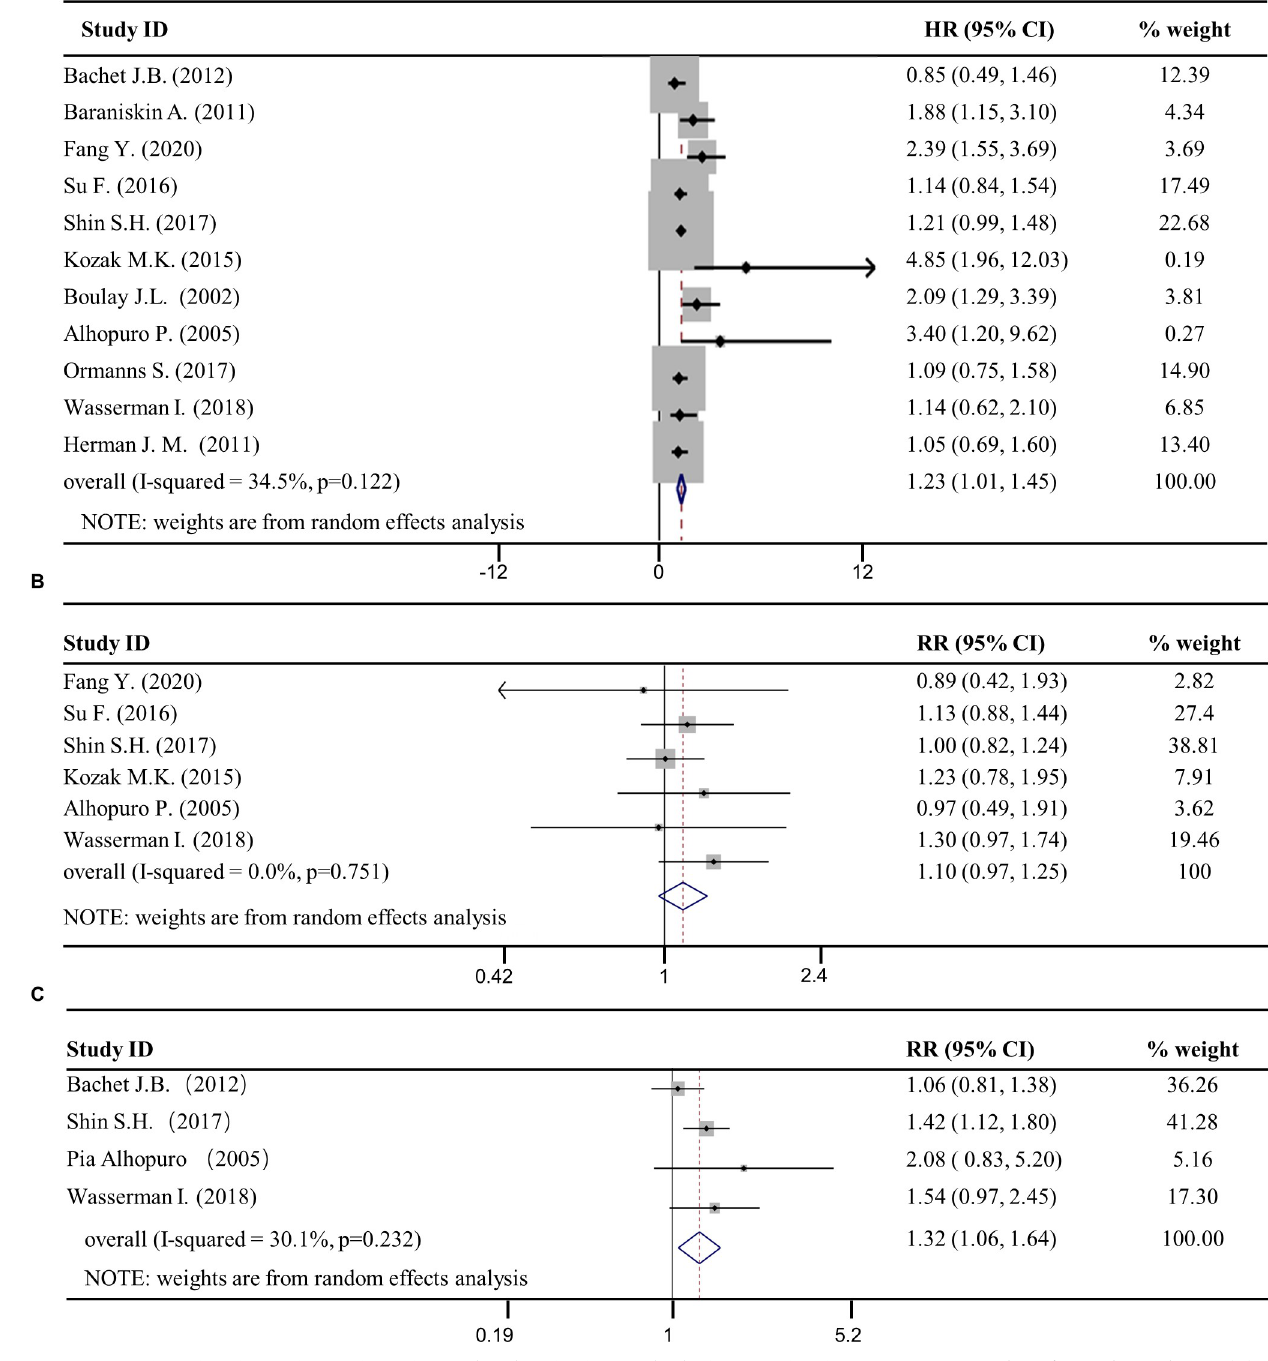
Fig 2. Forest plots of studies evaluating hazard ratios (HRs) and risk ratios (RR) of SMAD4 loss for resistance. Forest plots of 11 studies evaluating ( A ) HRs between SMAD4 neg and SMAD4 pos population, ( B ) RRs of metastasis between SMAD4 neg and SMAD4 pos population and ( C ) RRs of recurrence between SMAD4 neg and SMAD4 pos population. CI, confidence interval; HR, Hazard ratio.